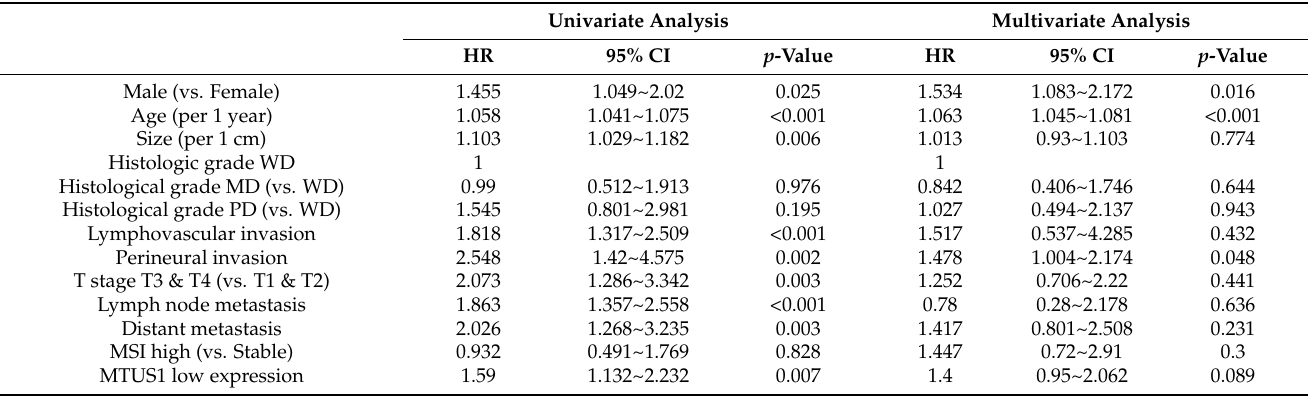
Table 3. Univariate and multivariate Cox regression analysis for overall survival in patients with colorectal adenocarcinoma ( n =